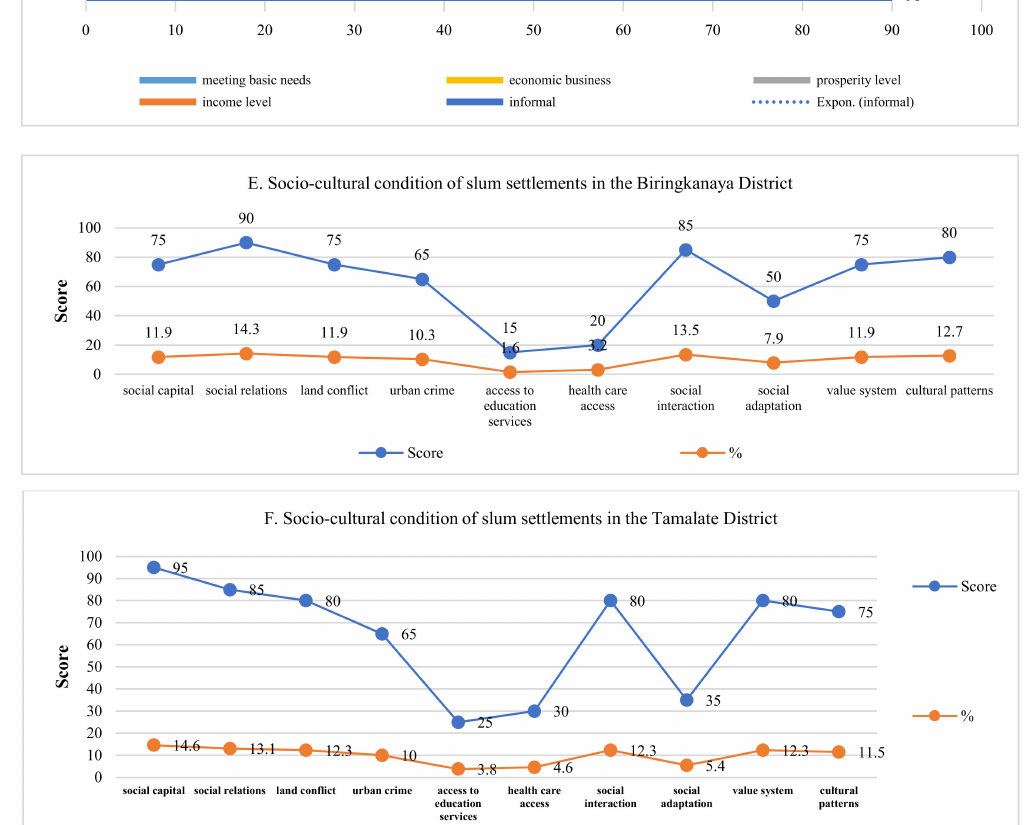
Figure 8. Conditions of infrastructure, economic, and socio-cultural services of slum settlements in ( A , C , E ) Biringkanaya and ( B , D , F ) Tamalate Districts, Makassar. Source: Primary Data,